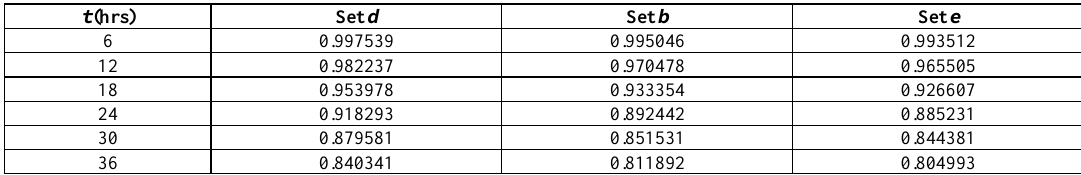
Table 3. The bitcoin dependability under sets d , b , and e